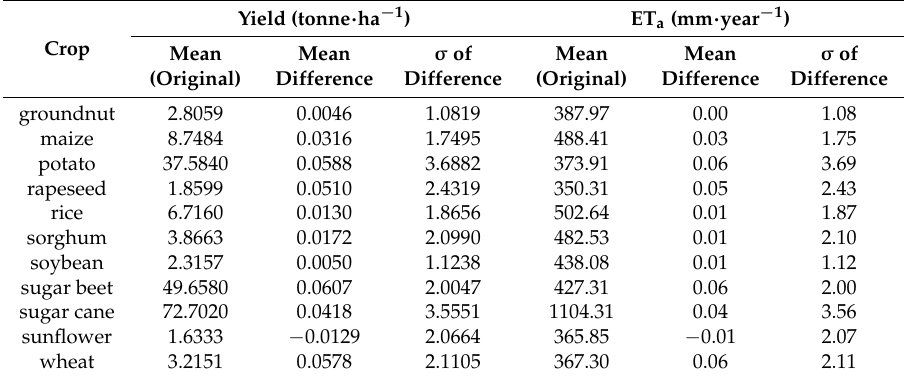
Table 2. Difference between original and interpolated values for paired pixels for yield and ET a